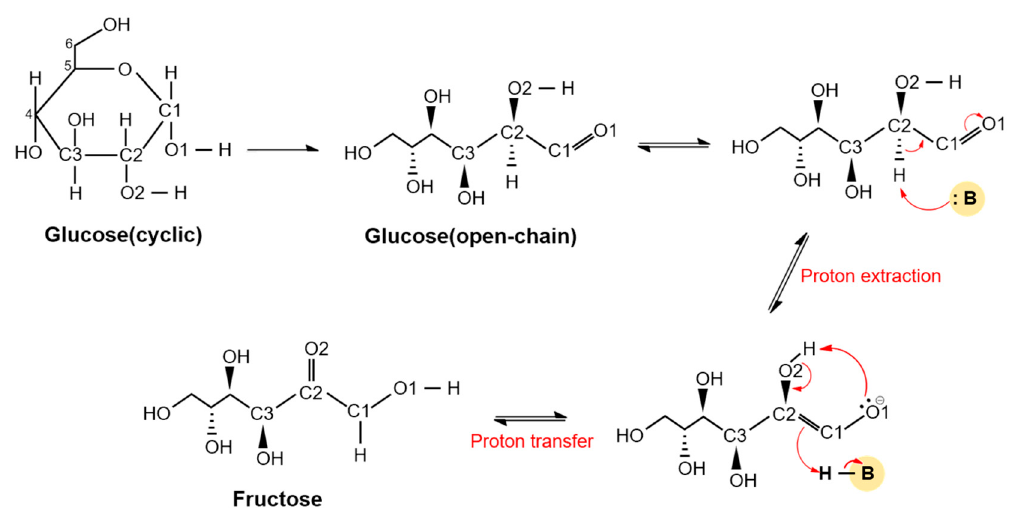
Figure 1. Mechanism of glucose ring-opening and isomerization over base catalysts.